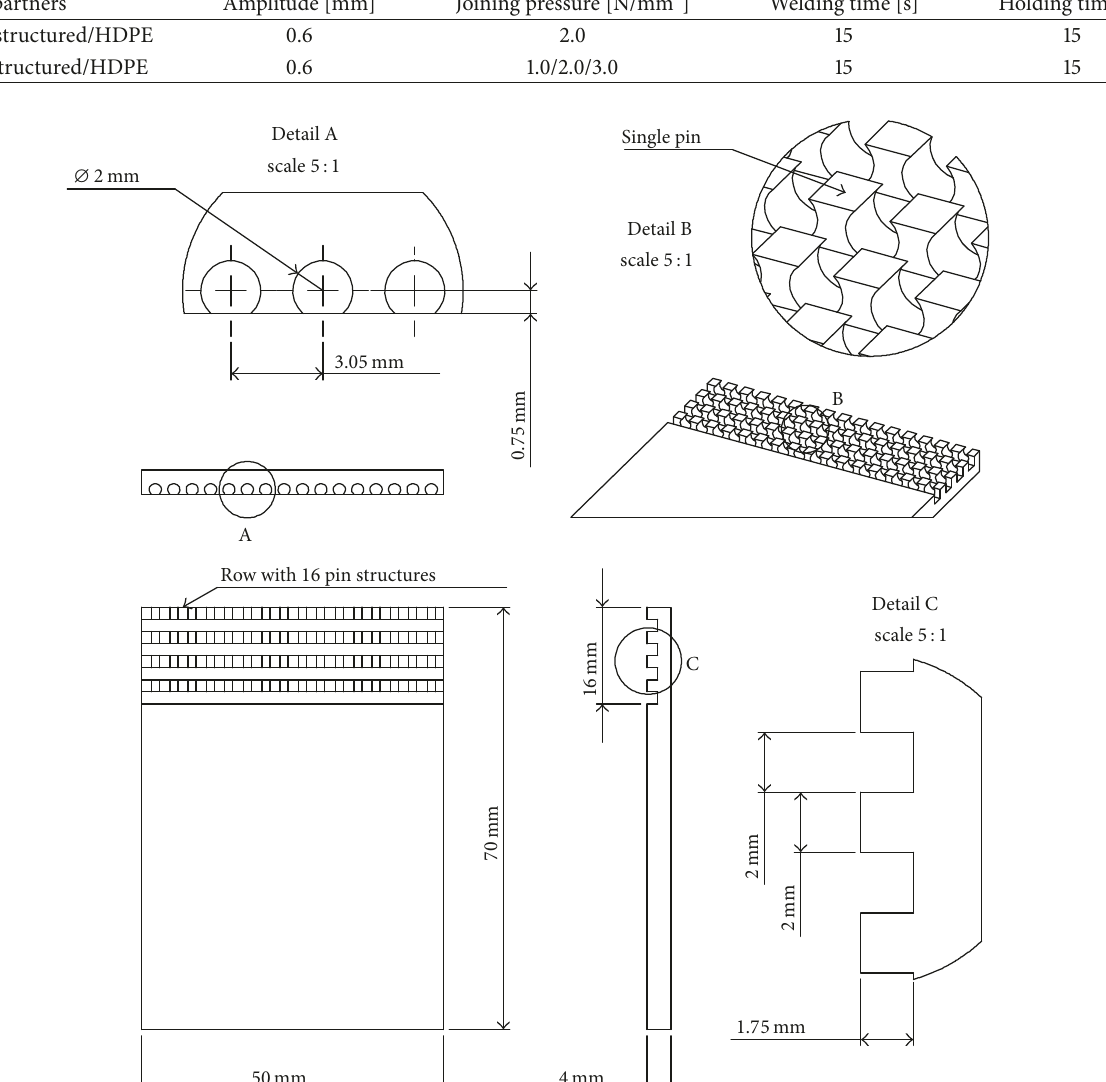
Figure 3: Geometrical dimensions of the used structuring tool with 64 pin structures involving undercut